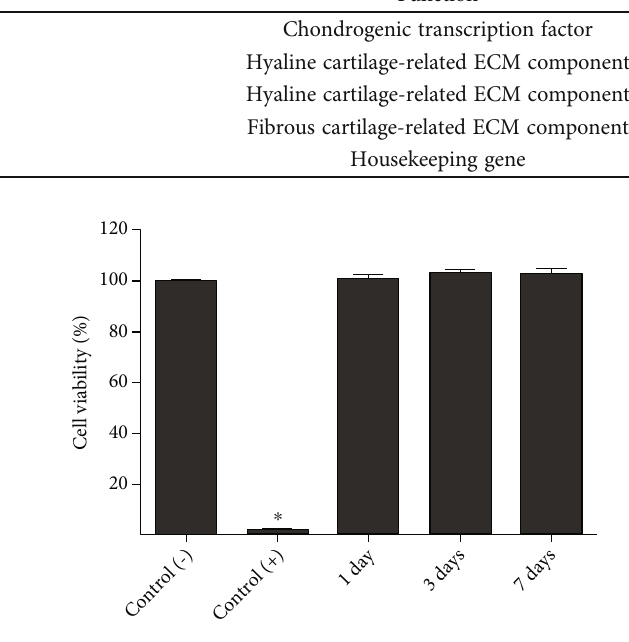
Figure 2: Cell viability assay results. hDPSCs were cultured with media conditioned for 1, 3, and 7 days with 3% agarose hydrogel. Nonconditioned medium and latex-conditioned medium were used as negative and positive cytotoxicity controls, respectively. MTS assay was carried out as described in Material and Methods, and bars show the mean ± SD . ∗ p < 0 : 001 compared to negative